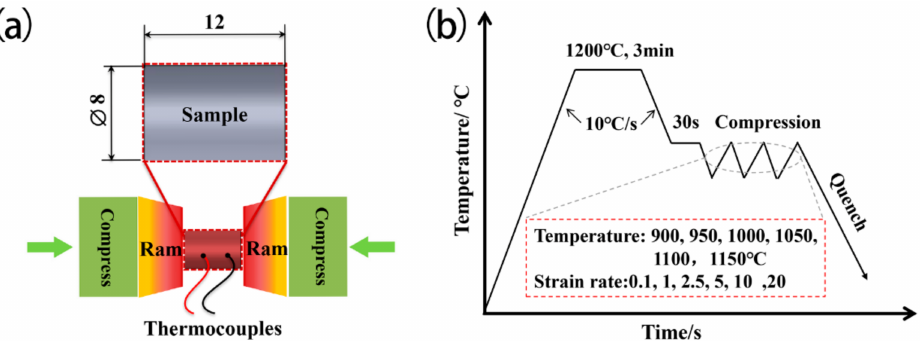
Figure 2. ( a ) Schematic plot of the hot deformation tests and ( b ) schematic plot of the hot deformation process